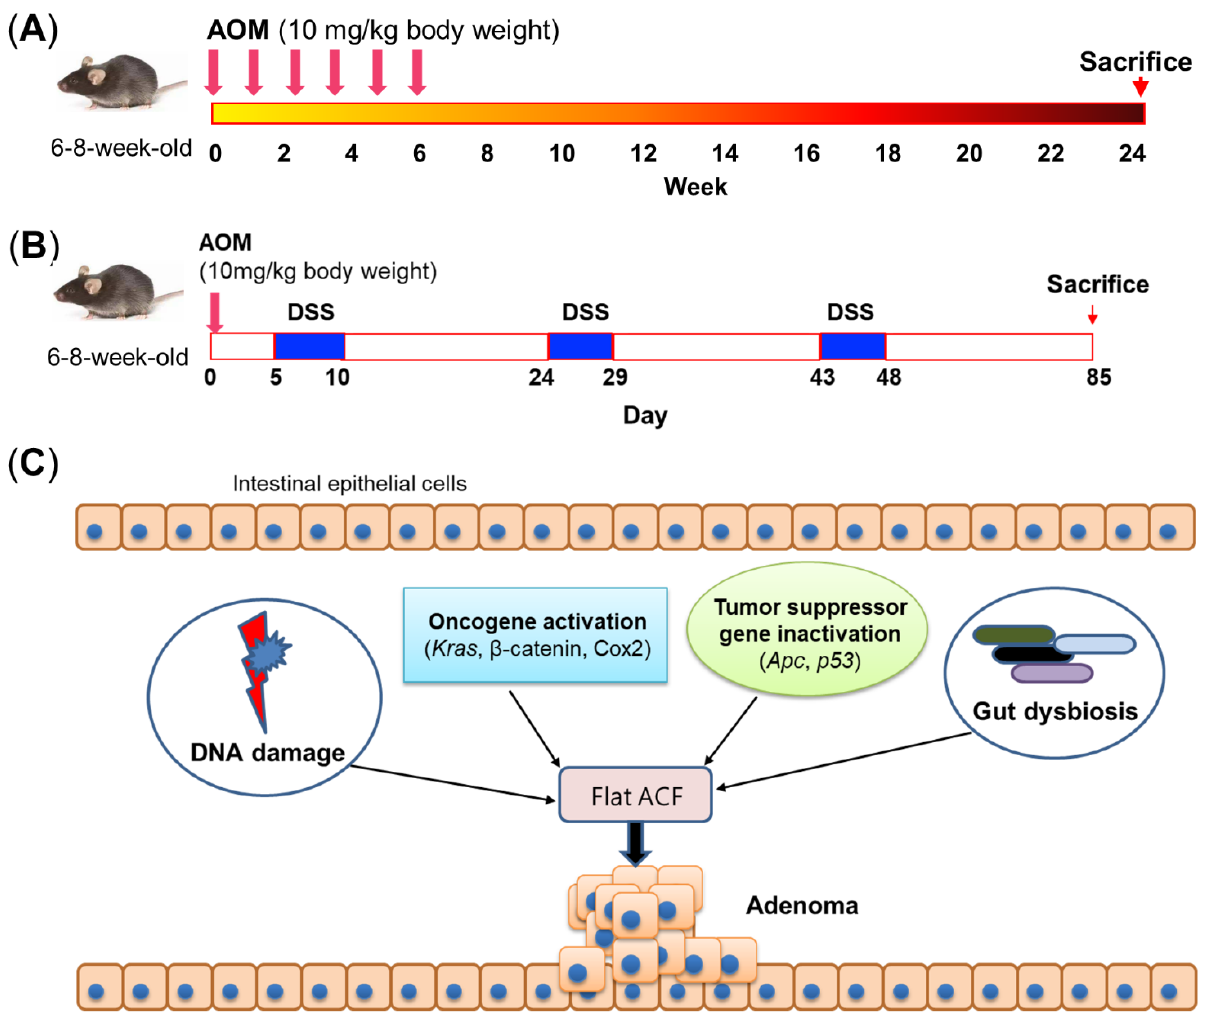
Figure 1. Carcinogen-induced mouse models. ( A ) Schematic of commonly used method of AOM treatment. Mice are provided a total of 6 AOM doses (10 mg/kg intraperitoneal injection per week), and mice can develop colon adenomas about 24 weeks after the last AOM injection. ( B ) Schematic of commonly used method of AOM/DSS treatment. A single intraperitoneal injection of AOM (10 mg/kg body weight) is first provided, followed by three treatment cycles of 1–3% DSS in drinking water for 5 days and then regular water treatment for 14 days. Mice can develop colon